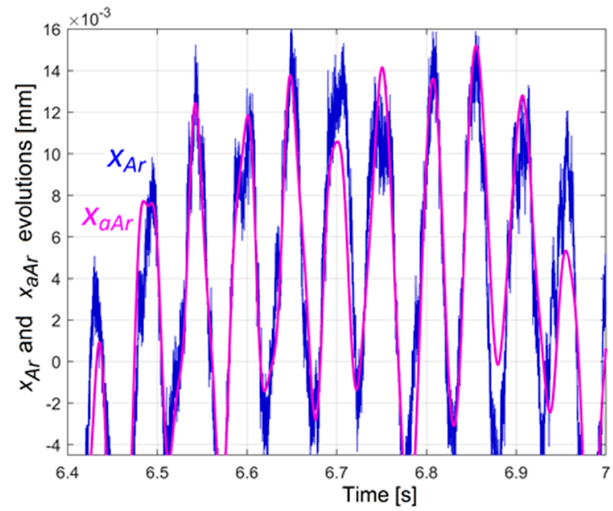
Figure 10. The evolution of x Ar and an analytical model x aAr (with n = 105) in area A of Figure 8.